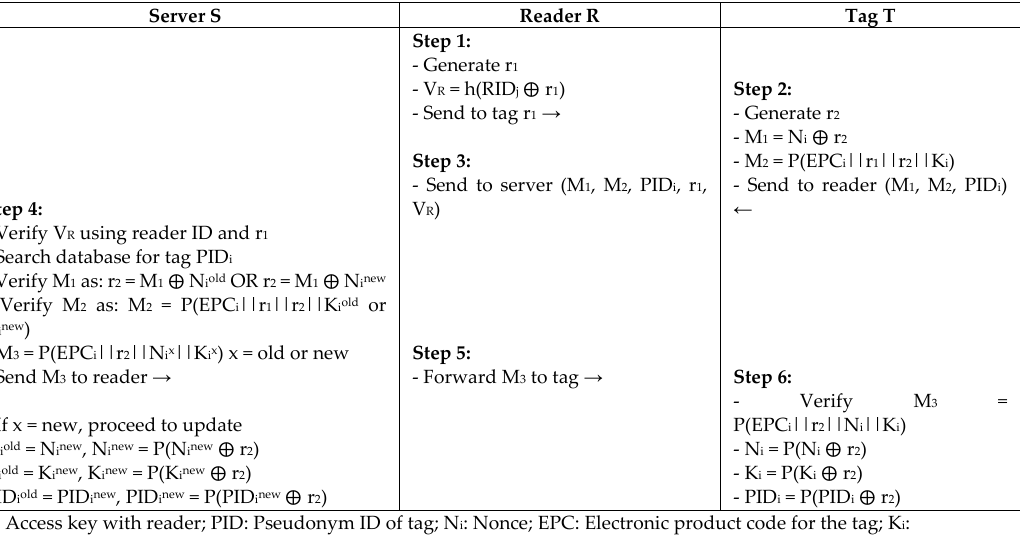
Figure 25. Ultra-Lightweight Reader–Tag Mutual Authentication Protocol (MACC) by Huang and Jiang.